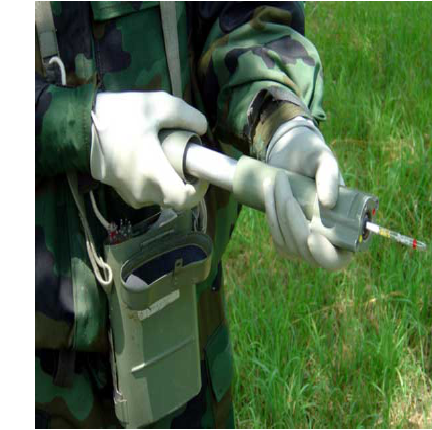
Figure 9 – Method of detection of toxic chemicals Рисунок 9 – Метод обнаружения токсичных